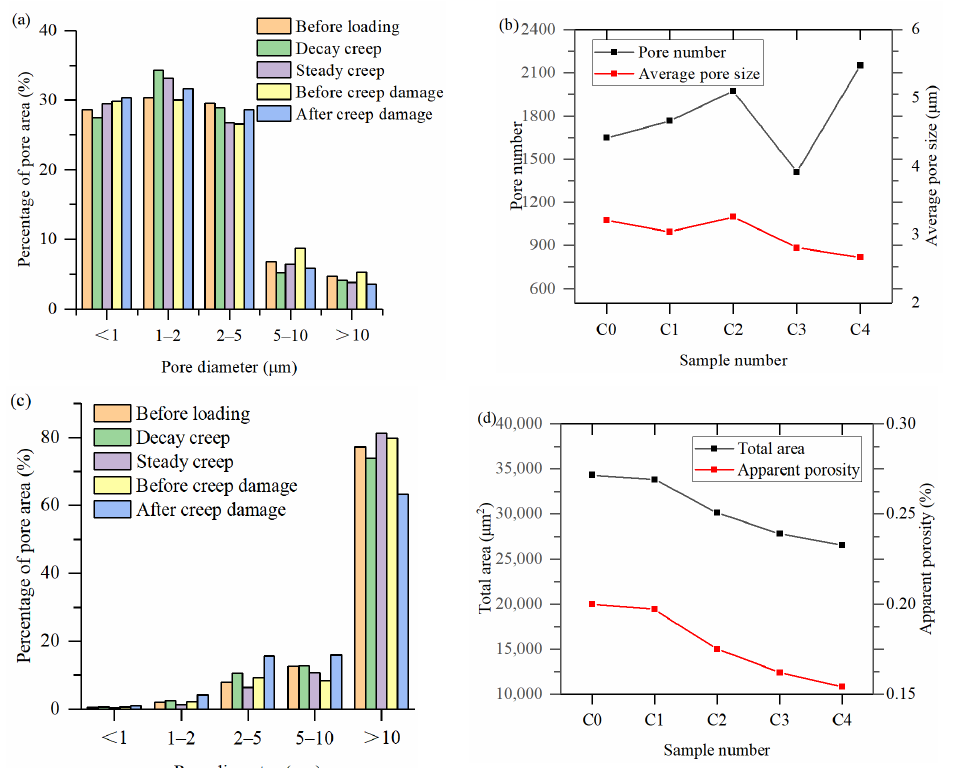
Figure 11. Quantitative analysis of pore space of remolded loess. ( a ) Histogram of pore content histogram; ( b ) number of pores and average pore size; ( c ) histogram of pore area distribution; ( d ) total pore area and apparent porosity.